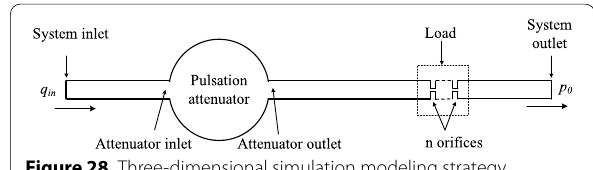
Figure 28 Three-dimensional simulation modeling